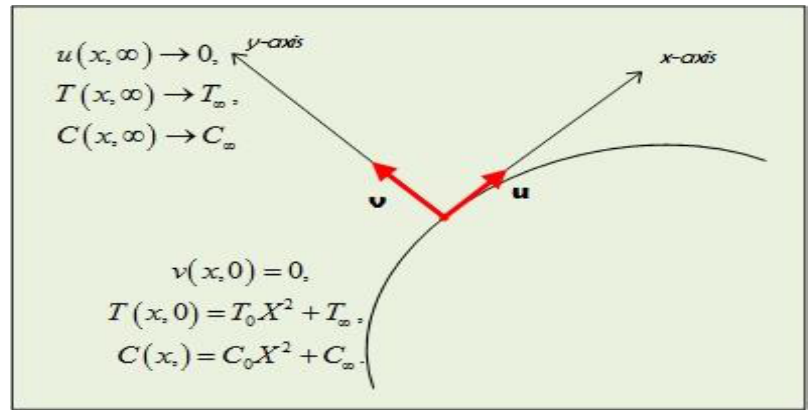
Figure 1. Flow geometry of the fluid flow system MHD-SGFM .